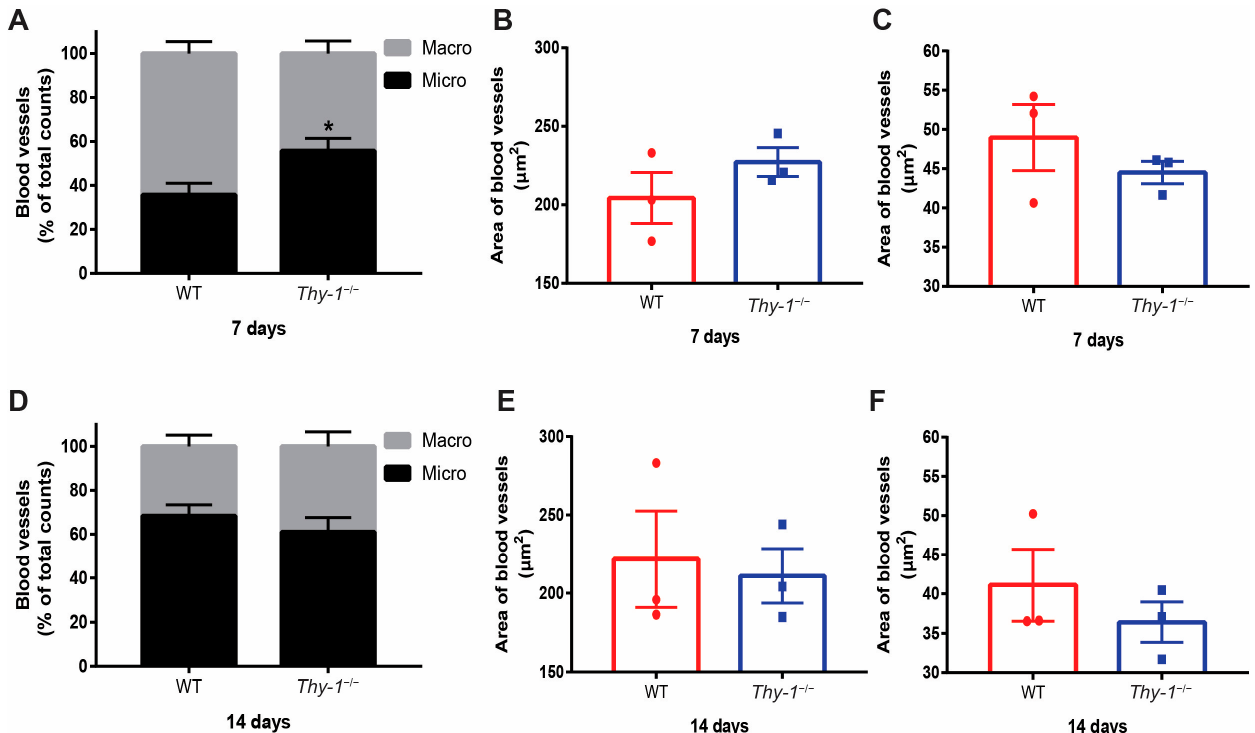
Figure 3. Estimating macro and microvascular blood vessels in the wounded area of WT and Thy-1 − / − mice. ( A ) Estimation of the percentage of macro and microvascular blood vessels in the wounded area on day seven after injury in WT ( n = 3) and Thy-1 − / − mice ( n = 3). ( B ) Estimation of the area of macrovascular; or ( C ) microvascular blood vessels on day seven after injury in WT and Thy-1 − / − mice. ( D ) Estimation of the percentage of macro and microvascular vessels (using a cut-off of 100 μ m 2 ) as in A, but on day fourteen after injury ( n = 3, per group). ( E , F ) Estimation of the area of macrovascular ( E ) or microvascular ( F ) blood vessels on day fourteen after injury in WT and Thy-1 − / − mice. Values are presented as mean ± SEM * p -value < 0.05.